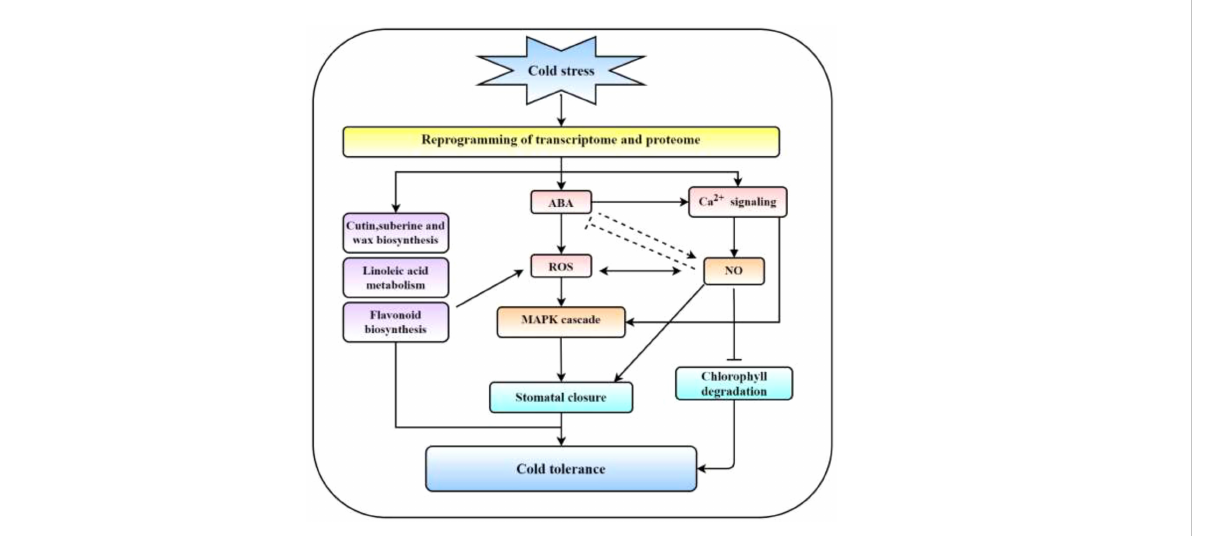
FIGURE 7 Ca 2+ signal, ABA, and MAPK cascade comodulated cold tolerance schematic model. Under cold stress, the transcriptome and proteome are reprogrammed, causing signi fi cant responses in MAPK cascade, Ca 2+ signaling, ABA signaling, cutin, suberine and wax biosynthesis, linoleic acid metabolism, NO signaling and fl avonoid biosynthesis. Ca 2+ activates NOS to promote NO production and inhibit Chl degradation. Ca 2+ signal, ABA and MAPK cascade form the regulatory network and synergistic role in ROS and induction of stomatal closure. These pathways together form a network that regulates cold resistance in R. chrysanthum